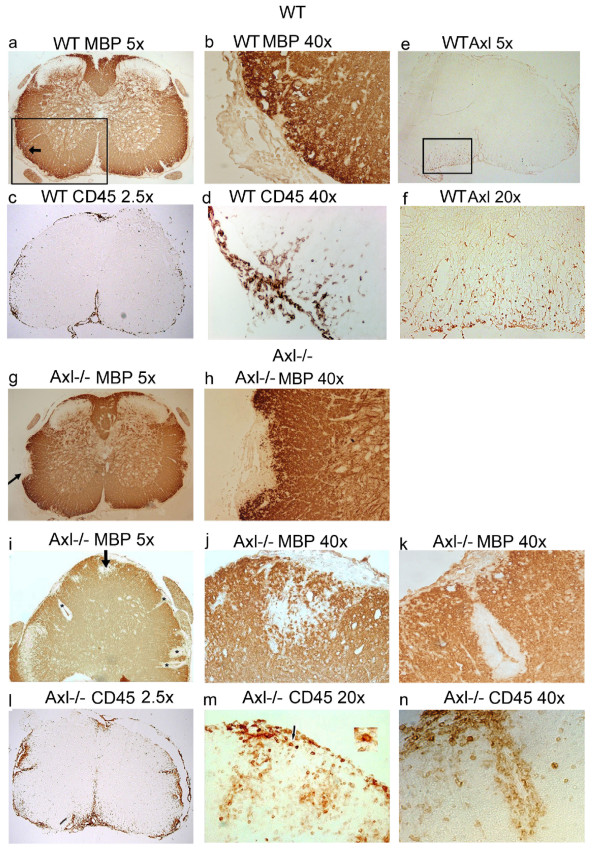
Demyelination and infiltration of CD45+ cells in spinal cords of Axl-/- mice are enhanced relative to WT mice. Seven micron paraffin-embedded day 14 WT and Axl-/- spinal cord sections were stained with MBP or CD45 mAb's, and frozen sections were stained with an Axl pAb, and were visualized by DAB. Representative images of WT (a,b) and Axl-/- (g,h,i,j,k) spinal cord stained for MBP. Arrows in a,g,i denote areas of demyelination shown at 40× in b,h,j, respectively. Asterisks in i denote demyelinated lesions; higher magnification of one lesion at 40× is shown in k. e,f) images of a WT mouse stained for Axl; the boxed area in e is shown at 20× in f. c,l) low magnification images of WT (c) and Axl-/- (l) mice stained with CD45. d) serial section of b stained for CD45. Serial sections of j,k stained for CD45 are shown in m,n.